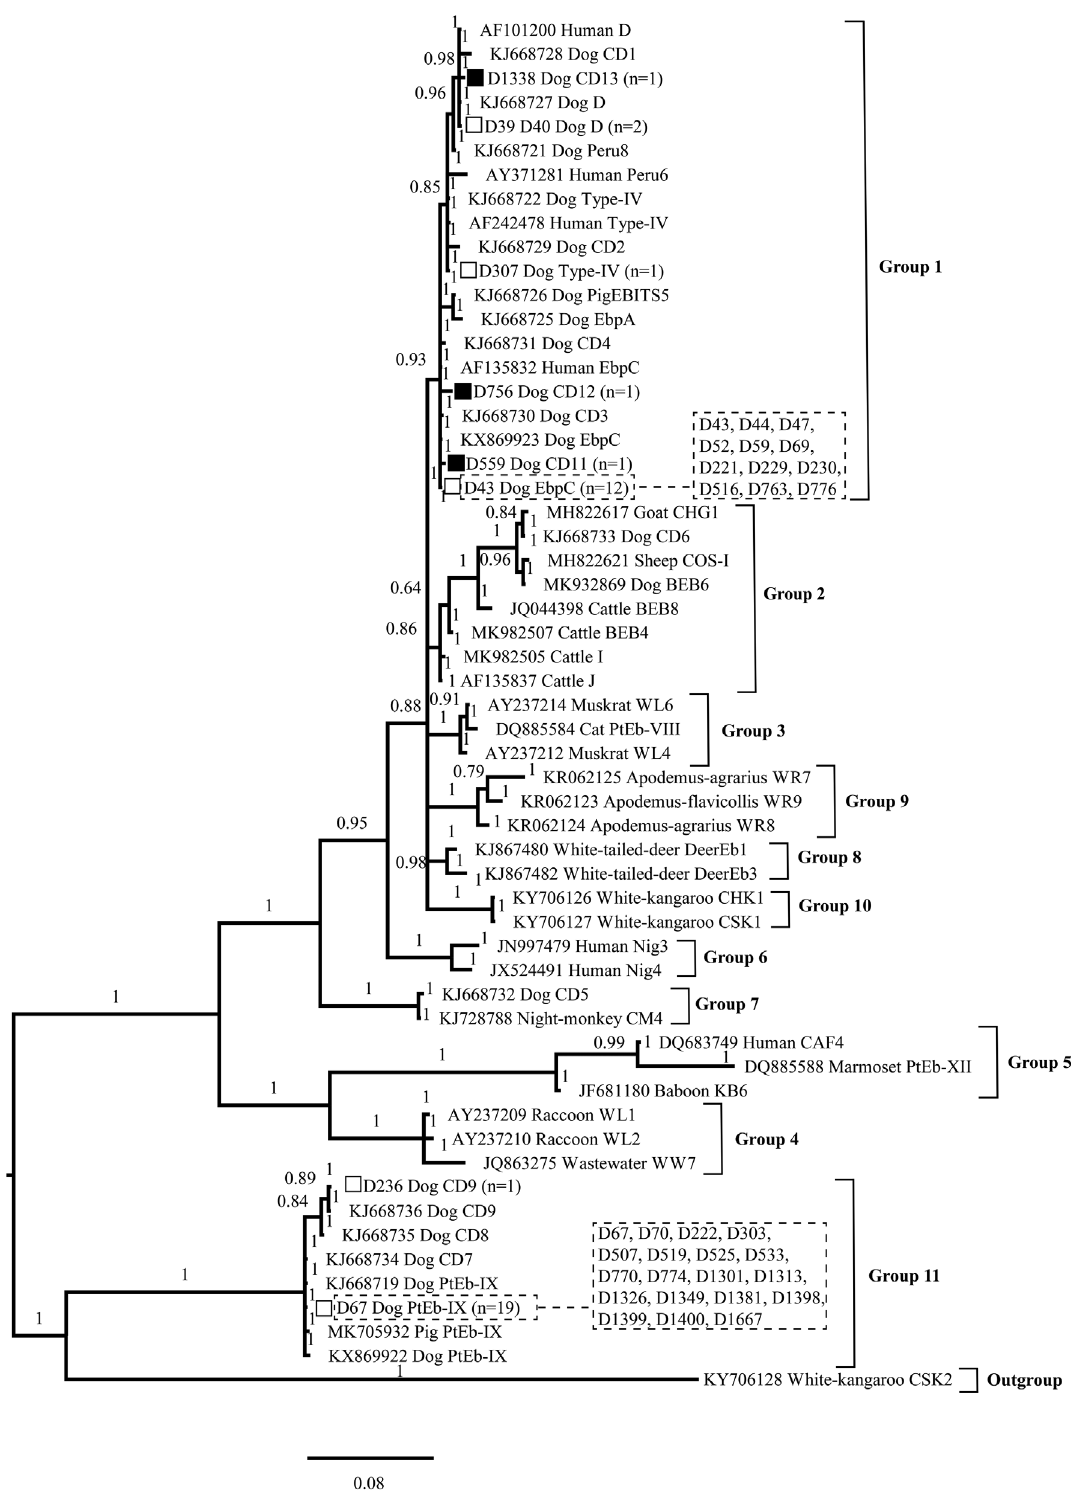
Figure 1. Phylogenetic tree based on Bayesian inference (BI) analysis of the Enterocytozoon bieneusi ITS sequences. Statistically signi fi cant posterior probabilities (>0.7) are indicated on the branches. Known and novel E. bieneusi ITS genotypes identi fi ed in the present study are indicated by empty and fi lled squares,